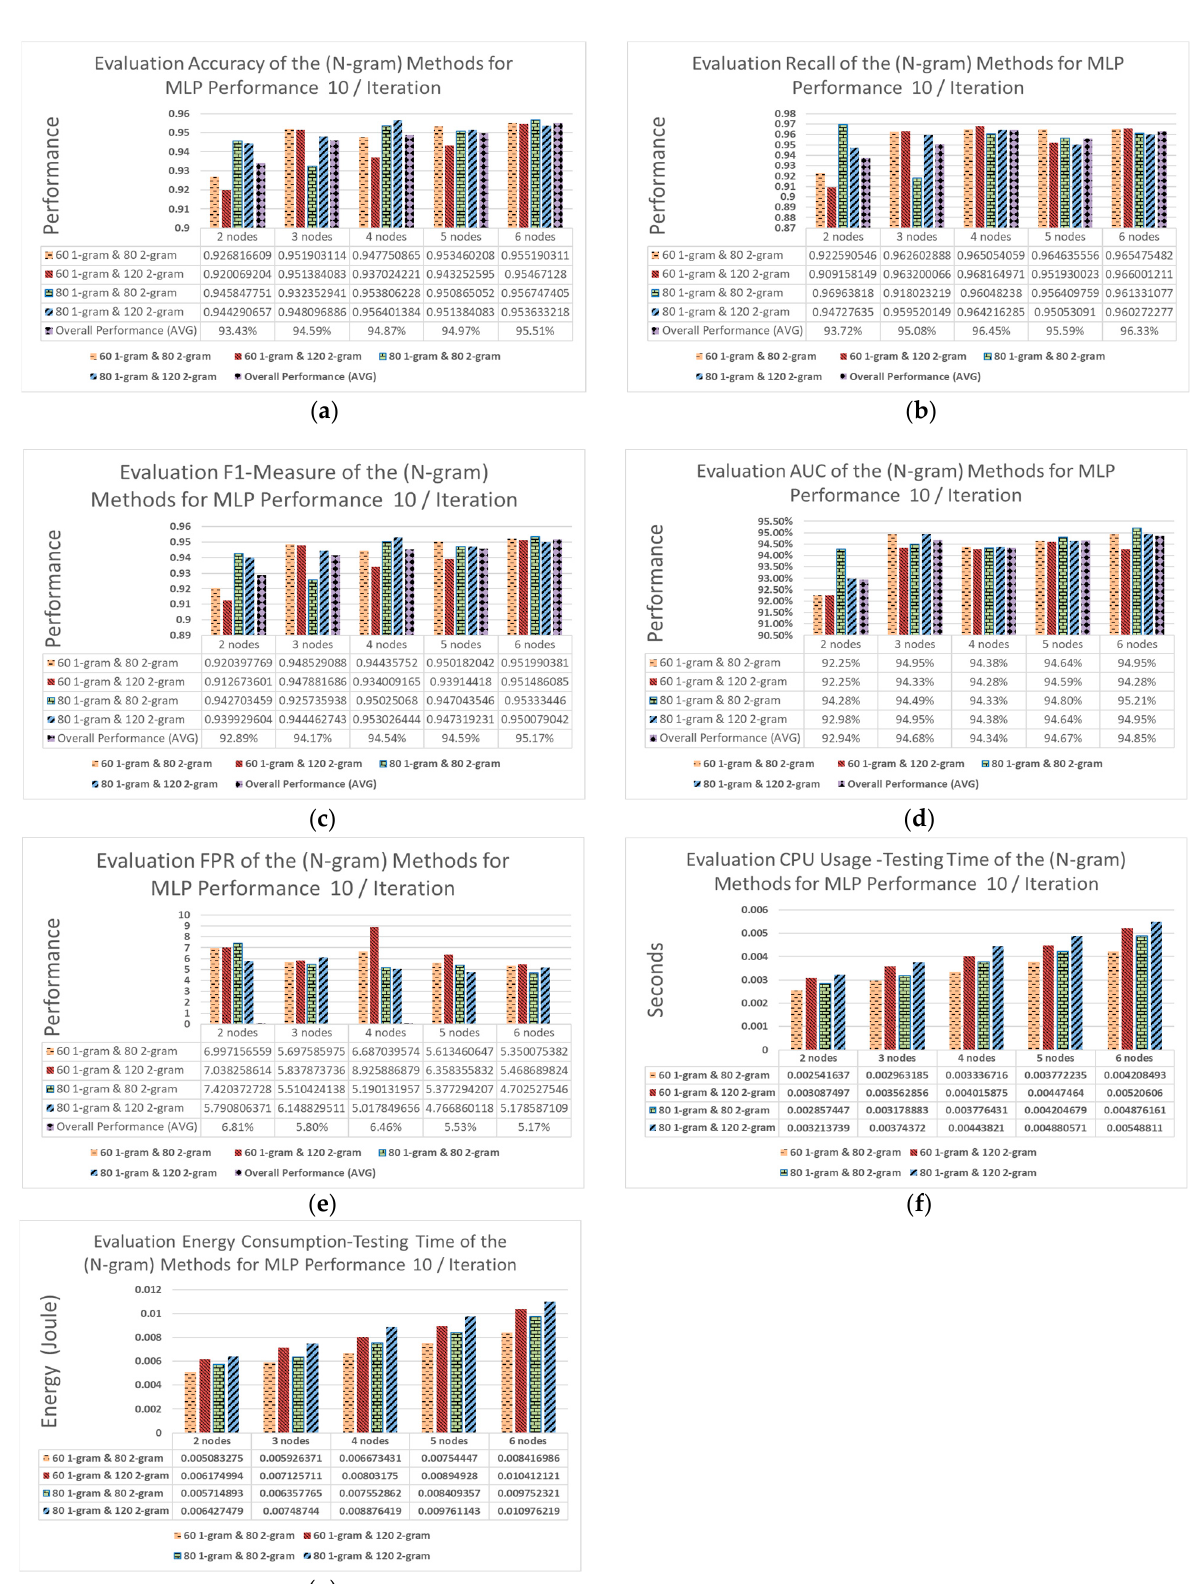
Figure 12. The performance of the model with respect to value using 2, 3, 4, 5, and 6 nodes and all 1-gram and 2-gram combinations by 10/Iteration: ( a ) accuracy, ( b ) recall, ( c ) F1-measure, ( d ) FPR, ( e ) AUC, ( f ) CPU usage—testing, ( g ) energy consumption—testing.